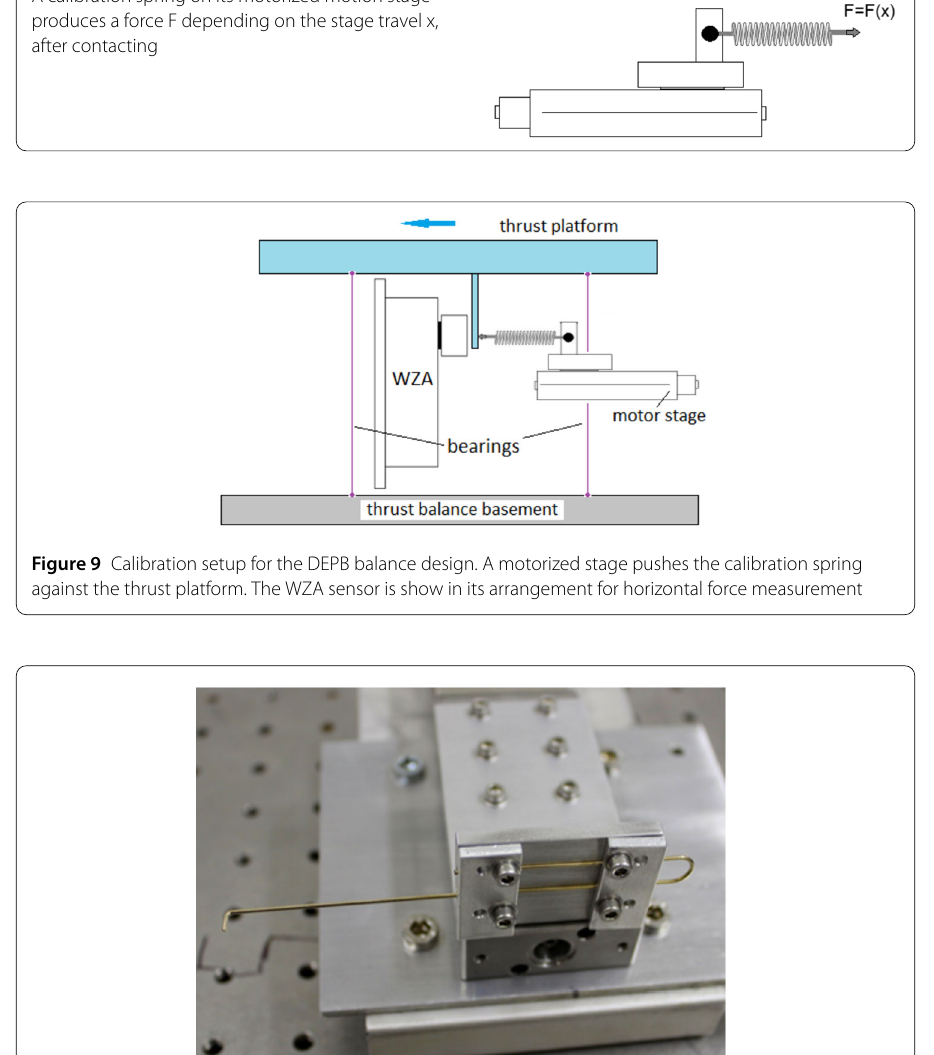
Figure 8 Principle of the DEPB calibration. A calibration spring on its motorized motion stage produces a force F depending on the stage travel x, after contacting